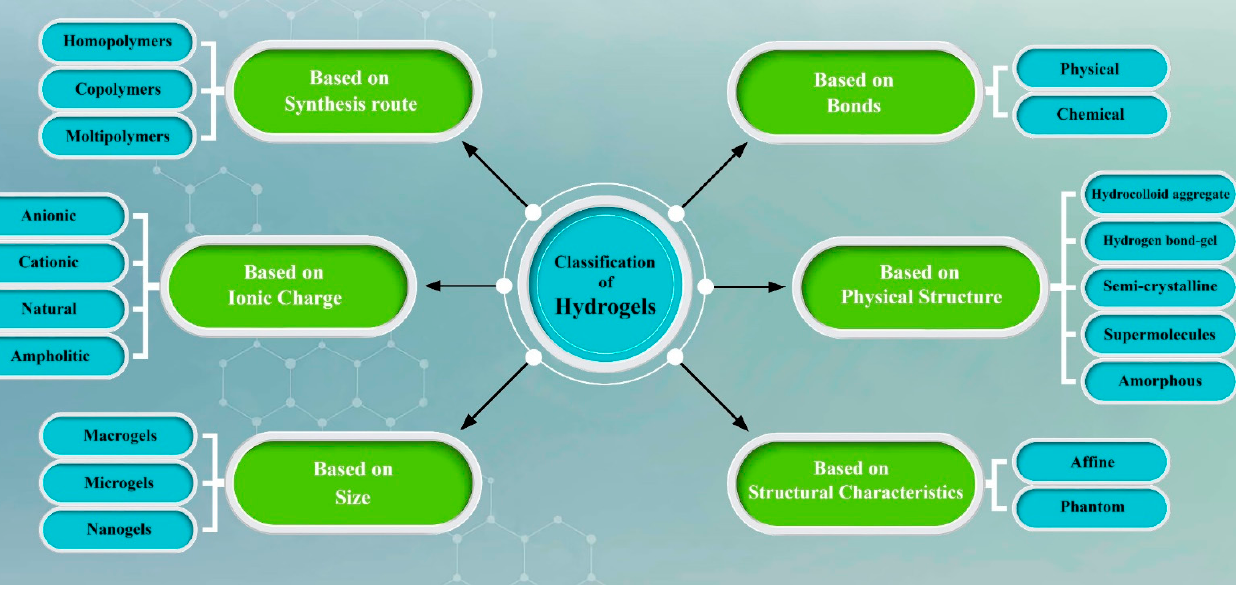
Figure 4. Schematic of classification of hydrogels. Photoshop 2020 was used to create this figure.